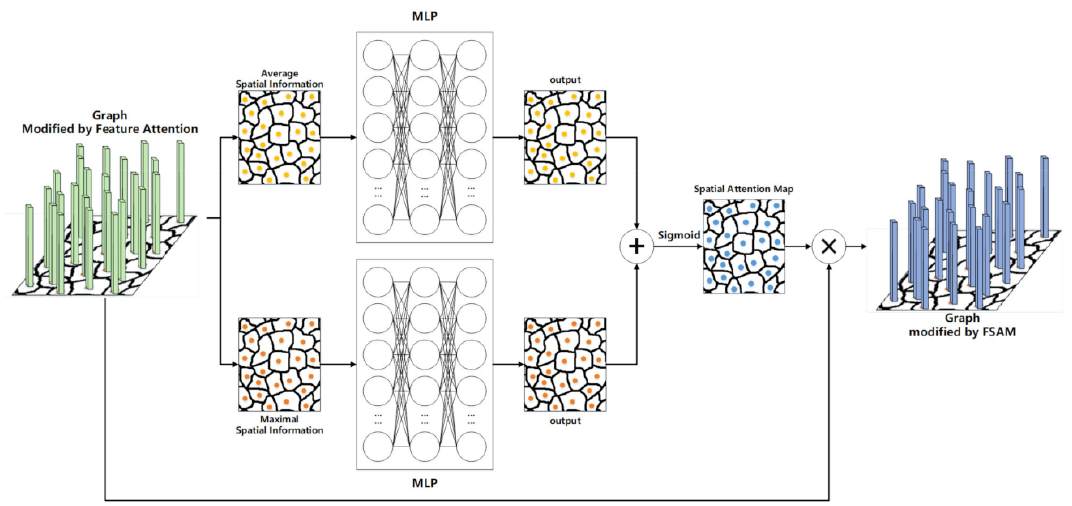
Figure 6. The overview of the spatial attention